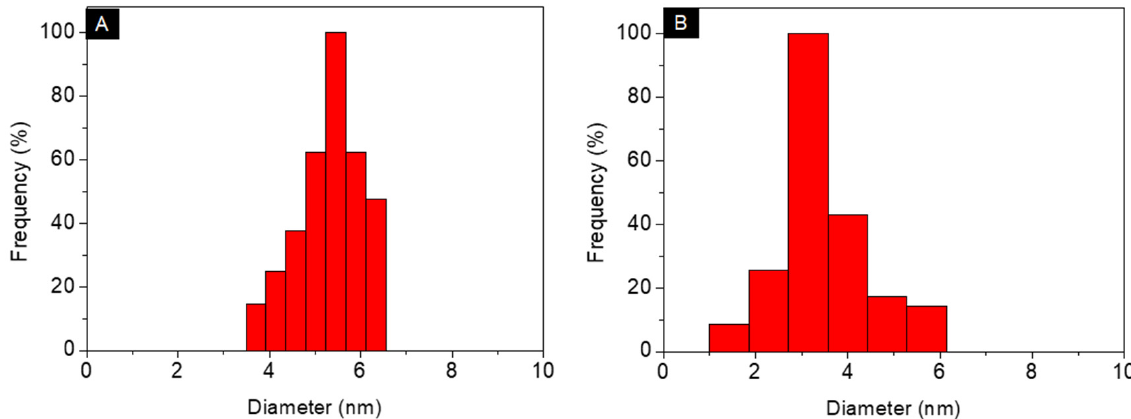
Figure 3. Particle size (diameter) histograms of the gold nanoparticles prepared with P5b ( A ) and Q5b ( B ) derived from TEM images presented in Figure 2.